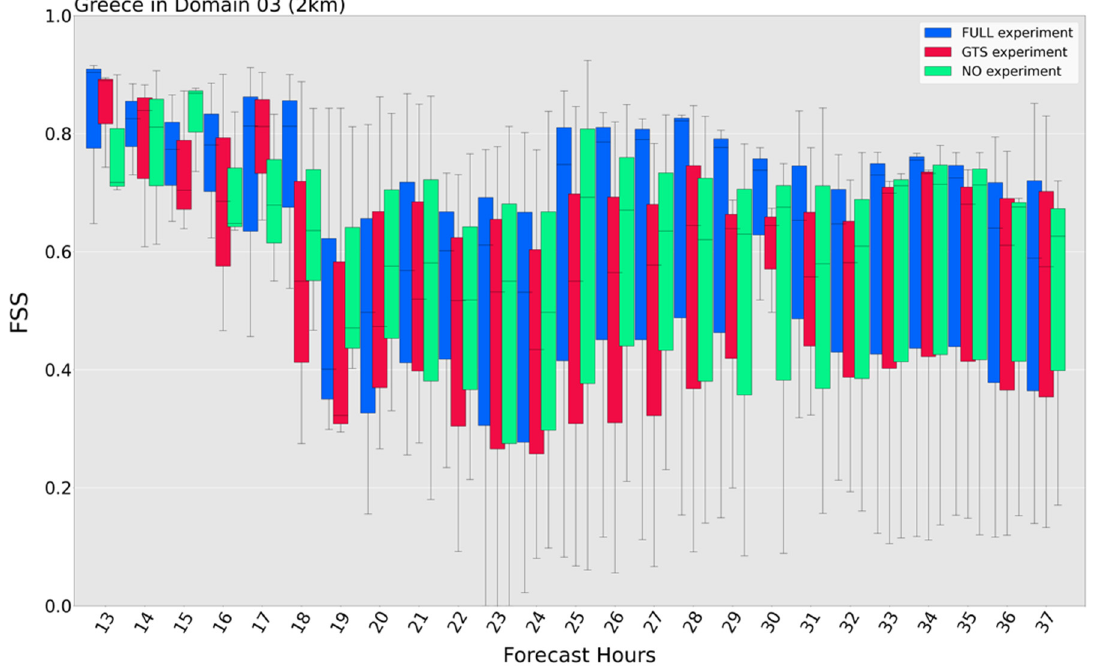
Figure 15. Hourly time series of precipitation accumulation FSS for 18 September 2020, for the area of Greece, at the 2 km domain. The blue boxplots correspond to the FULL experiment, the GTS experiment is depicted in red, and the NO experiment is depicted in green.